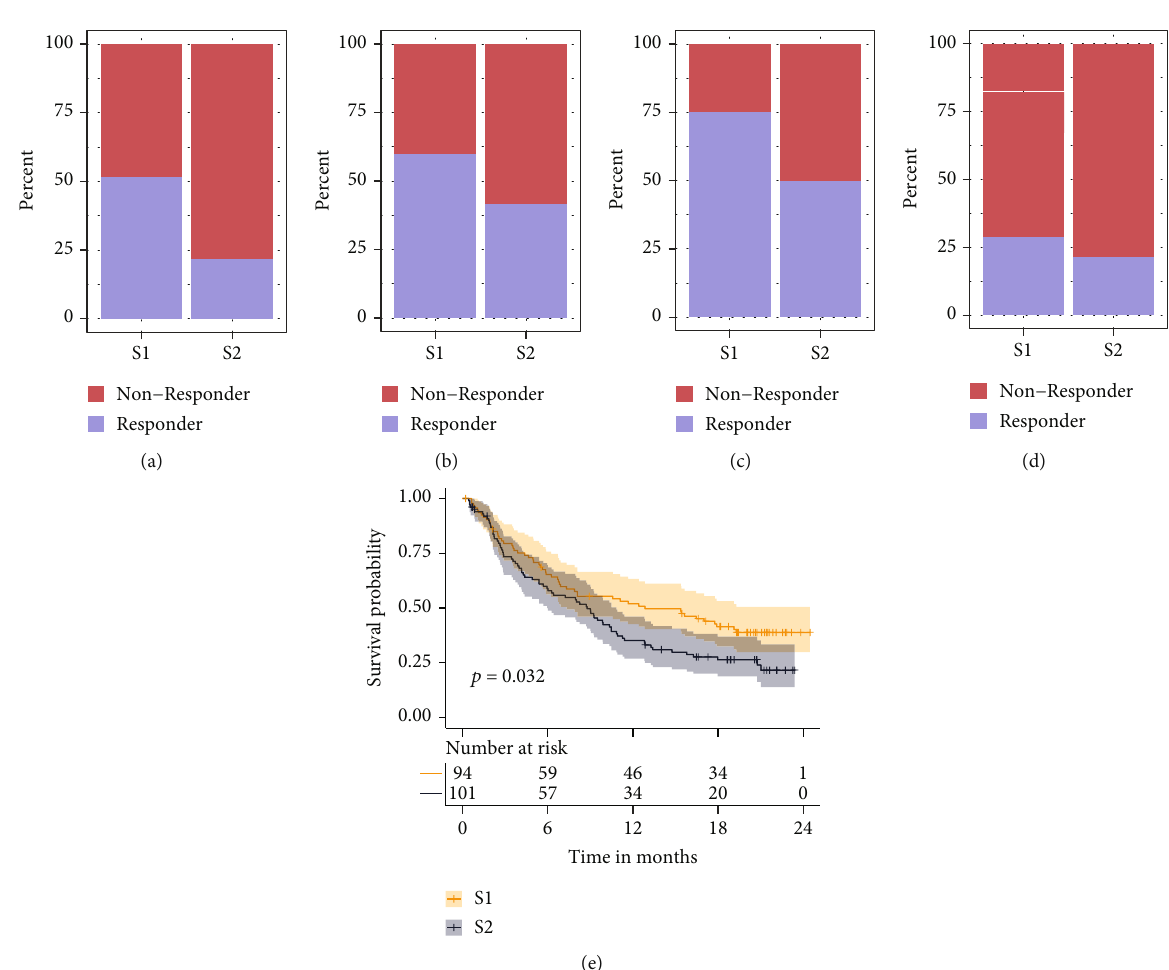
Figure 8: The correlation of NPC subtypes with response to ICB. (a) Analysis of response data of di ff erent subtype patients who had received ICB treatment (GSE35640). (b) Analysis of response data of di ff erent subtype patients who had received ICB treatment (GSE78220). (c) Analysis of response data of di ff erent subtype patients who had received ICB treatment (GSE111636). (d) Analysis of response data of di ff erent subtype patients who had received ICB treatment (IMvigor210). (e) Analysis of overall survival of di ff erent subtype patients who had received ICB treatment